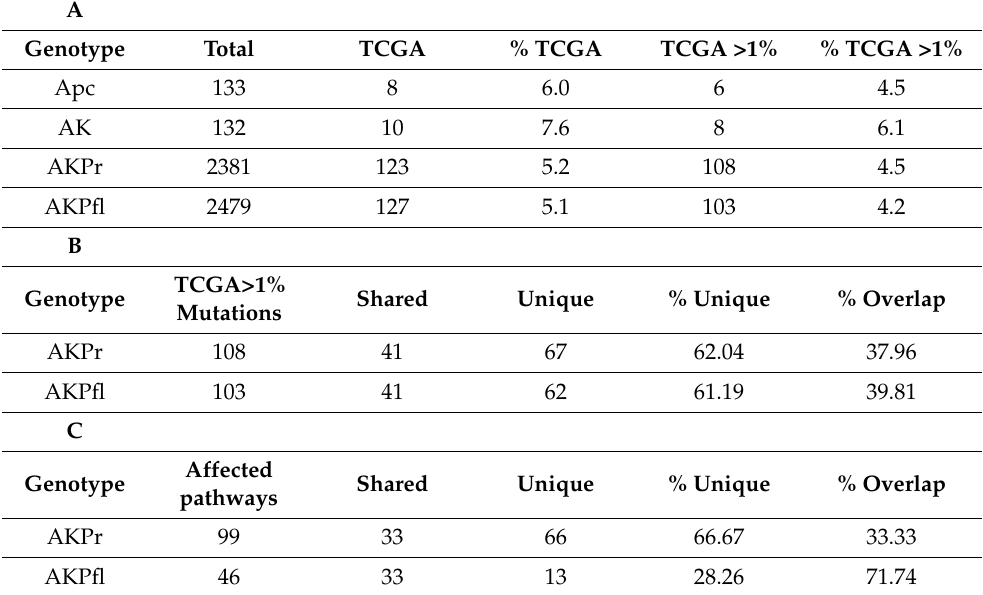
Table 1. A. Comparison of Mutations in the GEMM and The Cancer Genomic Atlas (TCGA) Dataset. “TCGA >1%” Refers to Mutations Present in >1% of Human CRC Tumors. B and C. Overview of Shared and Unique TCGA Mutations (B) and Resulting Affected Pathway (C) between AKPr and AKPfl